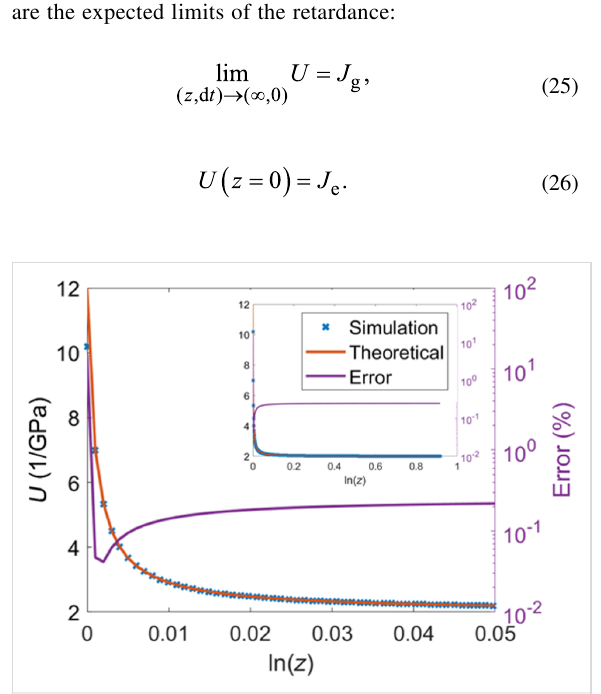
Figure 6: Retardance of the material plotted along the real axis of the z -plane using a logarithmic scale. The real axis of the z -plane does not contain information about harmonics but instead contains information about the zero-frequency components bounded by exponential func- tions with different time constants. The point z = 1 (this is the vertical- axis intercept on the plot, since the horizontal axis is ln( z ) and ln(1) = 0), which is located on the unit circle and hence corresponds to the Fourier transform, has a time constant of zero and can be thought of as a representation of the steady-state behavior. As the figure shows, the simulated response at z = 1 approaches the equilibrium compliance of the material. The response for large real values of z cor- responds to faster increasing exponentials, representing the system’s shorter-timescale response. The limit at z →∞ is approached as the sampling time becomes infinitely